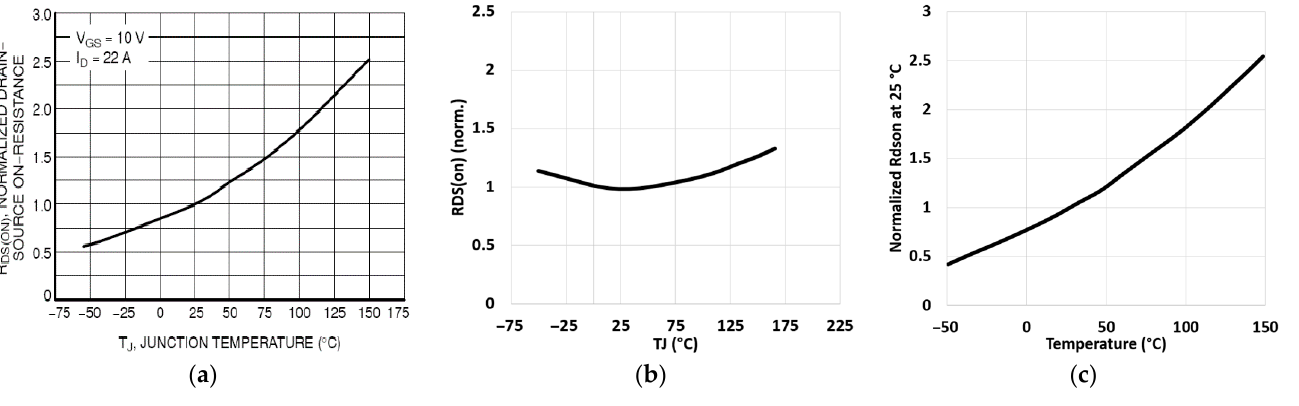
Figure 6. On-resistance versus temperature ( a ) Si MOSFET (ON Semiconductors